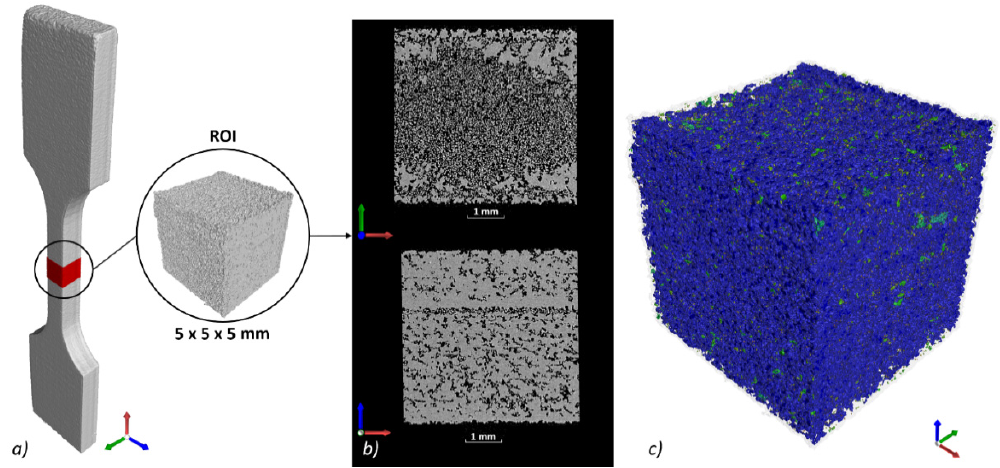
Figure 10. Porosity analysis: ( a ) sample PA12 Black XZ with analysed region of interest (ROI), ( b ) cross-sections in XY and XZ plane, ( c ) 3D view of porosity. The lowest porosity value was recorded for the samples made from PA 12 Smooth